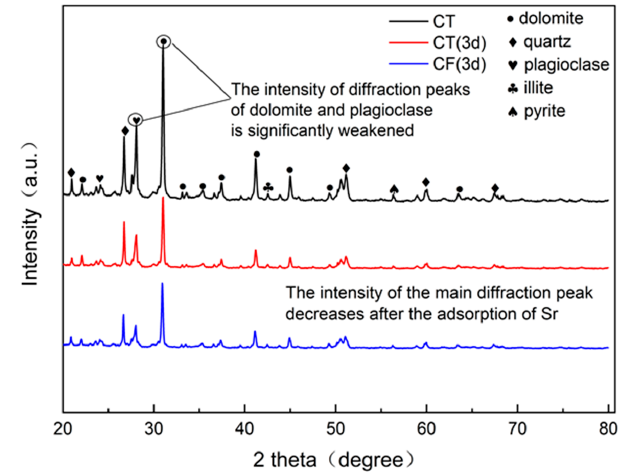
Figure 5. XRD spectra of CT and CF before and after